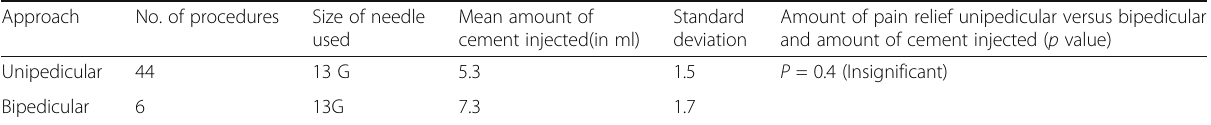
Table 2 Vertebral approach,size of needle used and amount of cement injected Approach